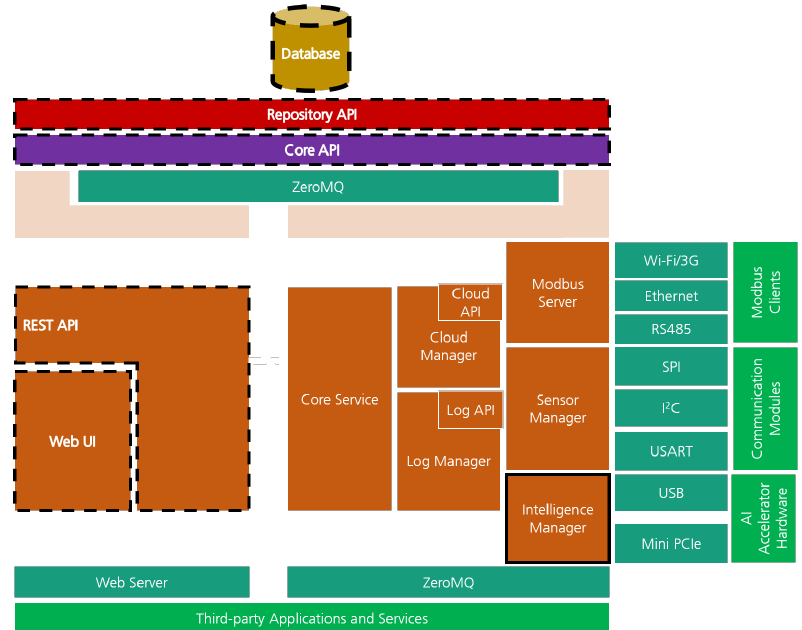
Figure 3. TIP4.0 High-level system architecture. Dashed black outline identifies the updated software modules, while the solid black outline identifies the new software